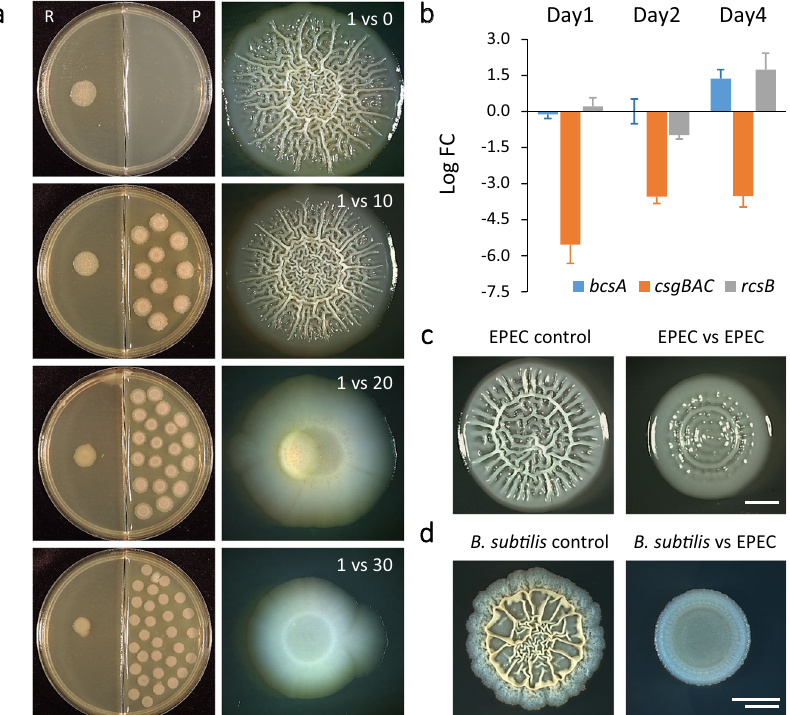
Fig. 3 Volatiles can inhibit bio fi lm development across bacterial species. a Enteropathogenic E. coli bio fi lm colonies (R — receiver) grown on solid LBNS medium in the presence of an indicated number of neighbouring B. subtilis colonies (P — producer) grown on B4 medium. Left — experimental setting, right — a close-up of the receiving colony. Colonies were incubated for 2 days at 30 °C. Images are representative of ( n > 3) independent experiments. b RT-PCR analysis of the expression levels of the indicated genes afters exposure to VCs. Presented are average fold-changes (FC) of expression in EPEC colonies ( n = 3) grown either alone, or in the presence of 30 neighbouring B. subtilis colonies, for indicated times. Bars represent standard deviation. The experiment was repeated three times with similar results. c E. coli bio fi lm colonies grown on solid LBNS medium either alone (EPEC control) or in the presence of 30 neighbouring EPEC colonies. Colonies were incubated for 2 days at 30 °C. Images are representative of ( n > 3) independent experiments. Scale bar 2 mm. d B. subtilis bio fi lm colonies grown on solid B4 medium either alone ( B. subtilis control) or in the presence of 30 neighbouring EPEC colonies grown on LBNS medium. Colonies were incubated for 2 days at 30 °C. Images are representative of ( n > 3) independent experiments. Scale bar 2